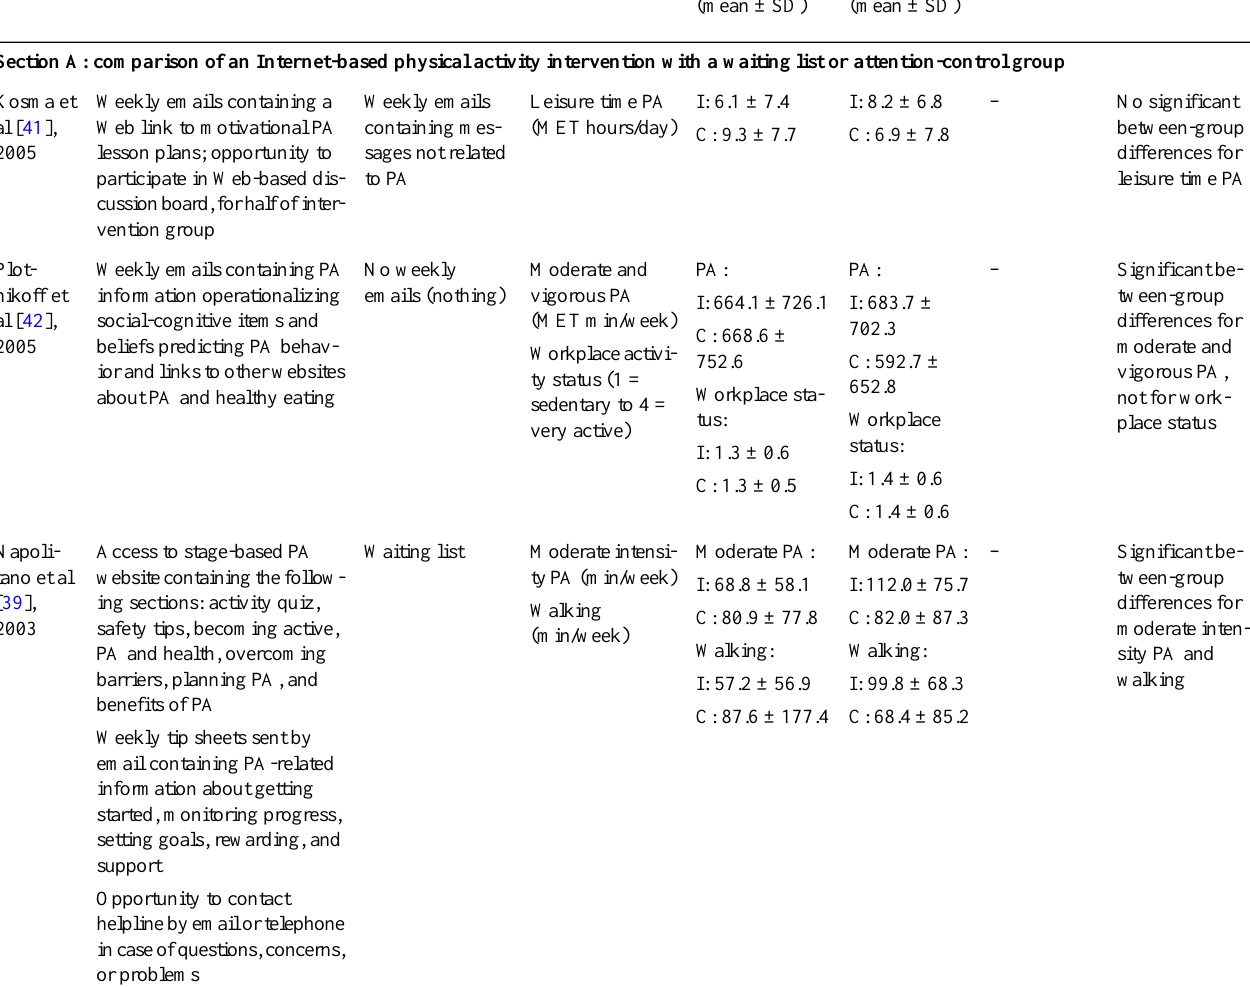
Section A: comparison of an Internet-based physical activity intervention with a waiting list or attention-control group